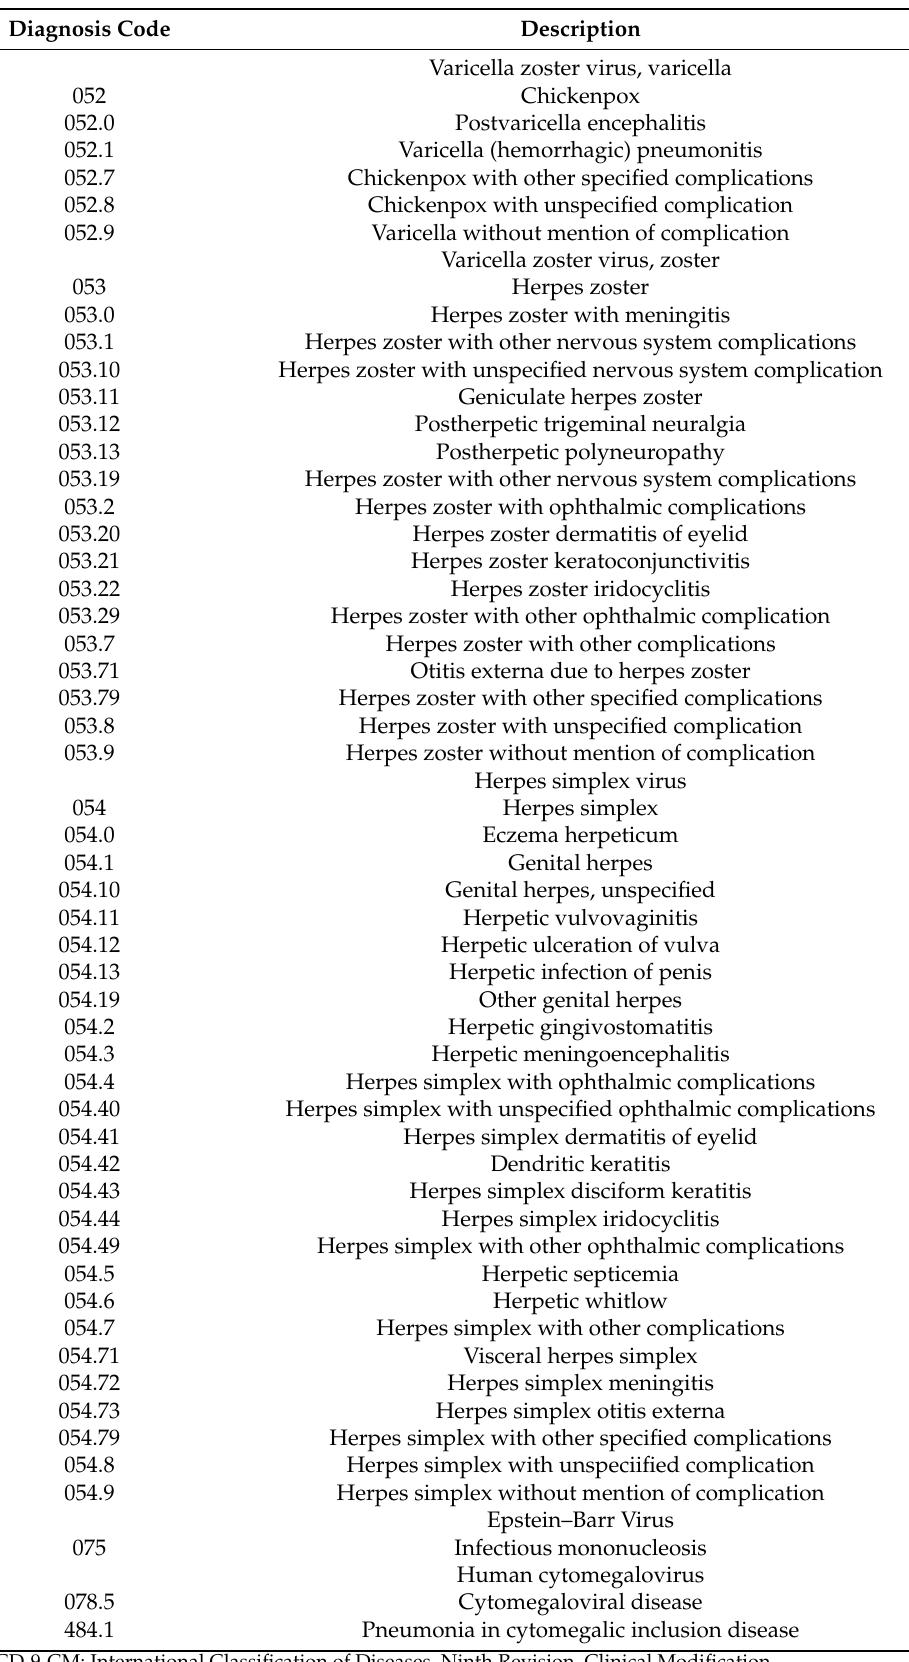
Table A2. ICD-9-CM codes used to identify a history of human herpesvirus